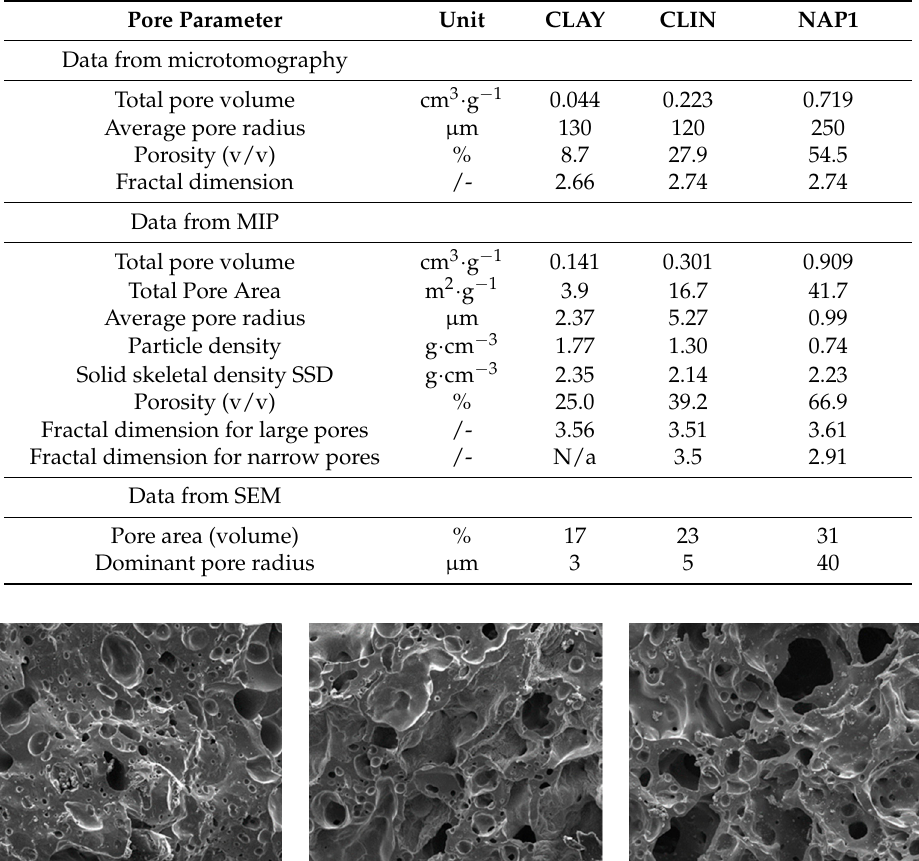
Table 2. Pore parameters of the studied LWAs.